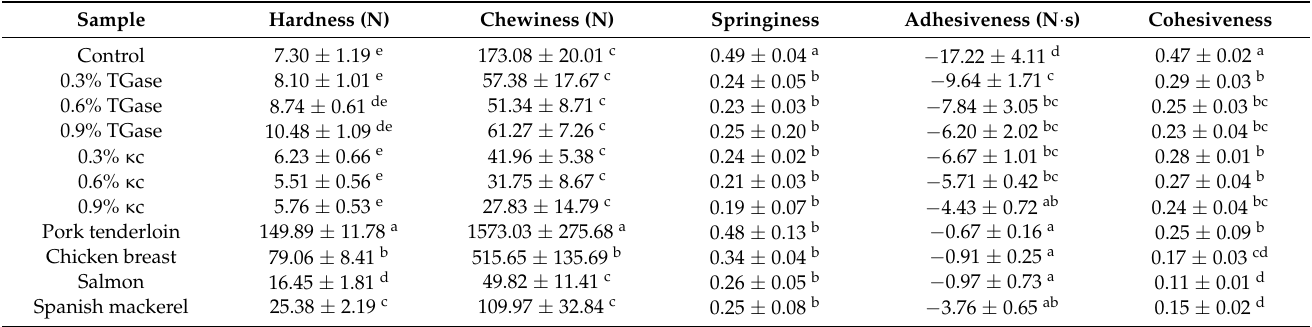
Table 1. Textural properties of raw 3D-printed meat mimics treated by TGase and κ c at 0, 0.3, 0.6 and 0.9% as well as those of raw animal meats.